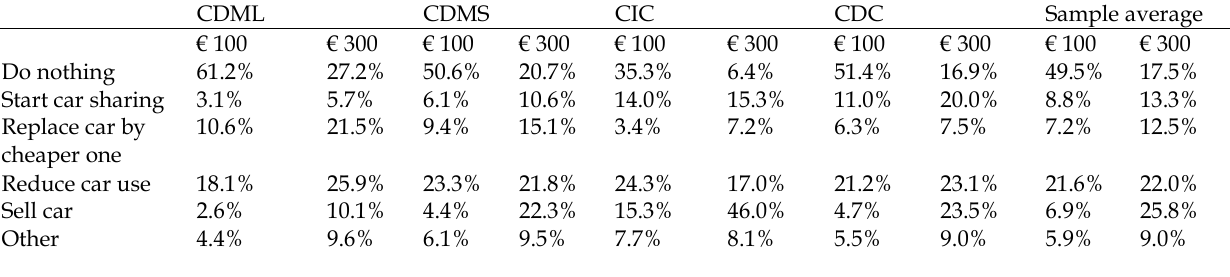
Table 6: Preferred adaption towards increasing car use costs of 100 euro/month and